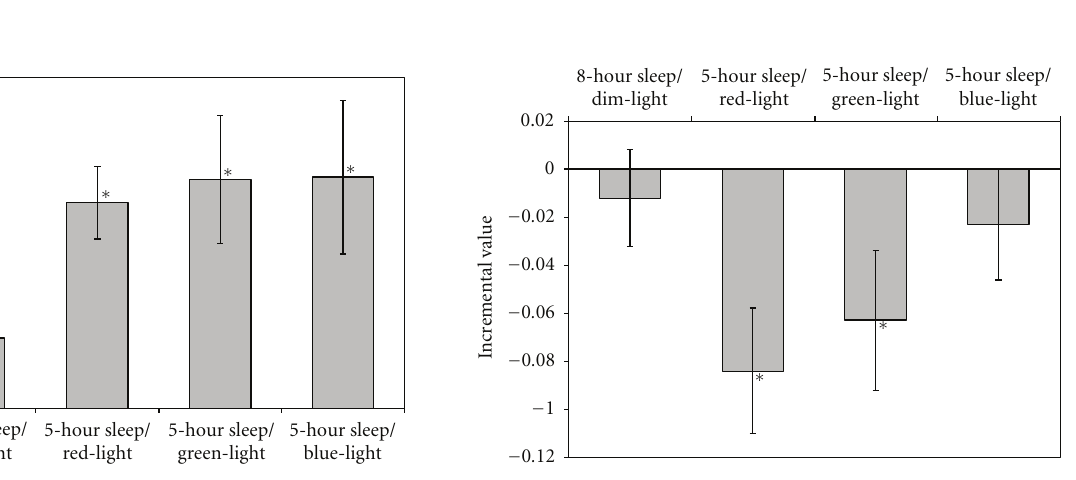
Figure 1: Di ff erences (incremental values) in the normalized leptin concentrations (mean ± SEM) relative to the 5-hour sleep/dim- light condition. Sample concentrations collected at 60, 90, and 120 minutes for the 8-hour sleep/dim-light condition, those for the 5- hour sleep/red-light condition, those for the 5-hour sleep/green- light condition, and those for the 5-hour sleep/blue-light condition were each normalized to the values obtained at 60, 90, and 120 minutes for the reference, 5-hour sleep/dim-light condition. These normalized values were averaged across subjects and times. The incremental values reflect the di ff erence in the averages of the four di ff erent sleep/lighting conditions from the 5-hour sleep/dim- light condition. Incremental values after the 8-hour sleep/dim-light condition and after all three lighting conditions were significantly ( P < 0 . 05) greater than those in the reference, 5-hour sleep/dim- light condition.